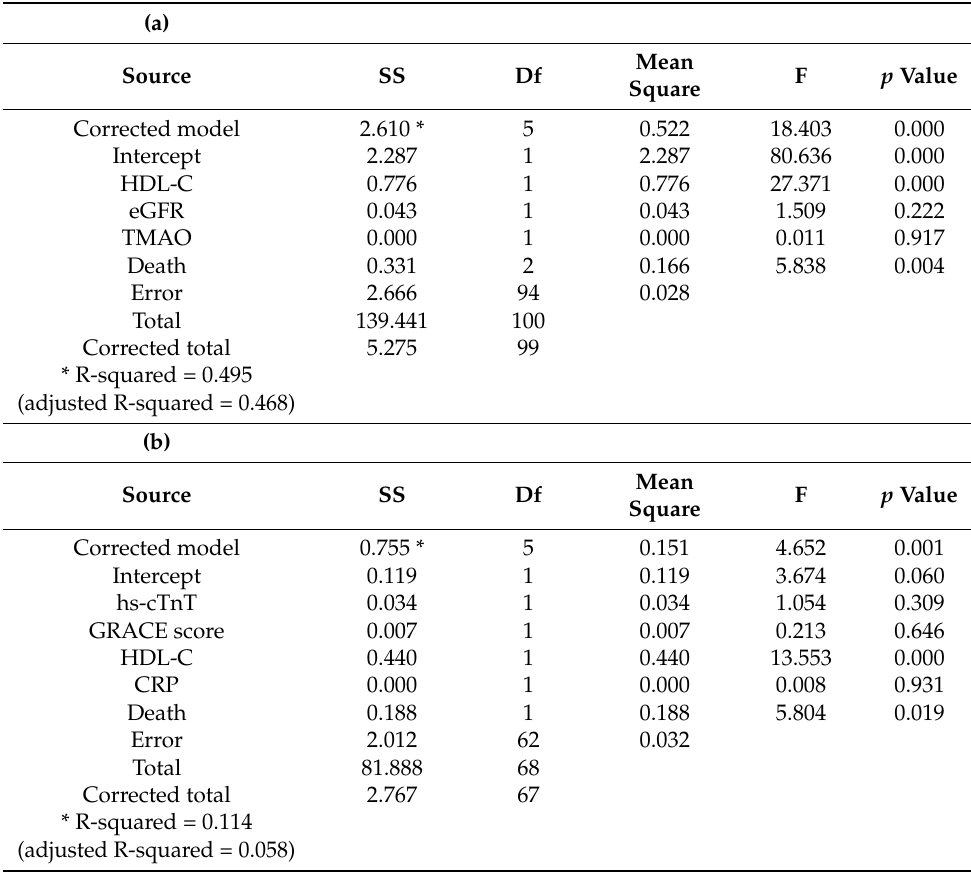
Table 2. Analysis of covariance (ANCOVA) of ABCA1/G1-mediated macrophage cholesterol efflux at 24 h adjusted for (a) HDL-C, eGFR and TMAO that significantly correlated with the dependent variable or (b) hs-cTnT, GRACE score, HDL-C and CRP, factors strongly associated with